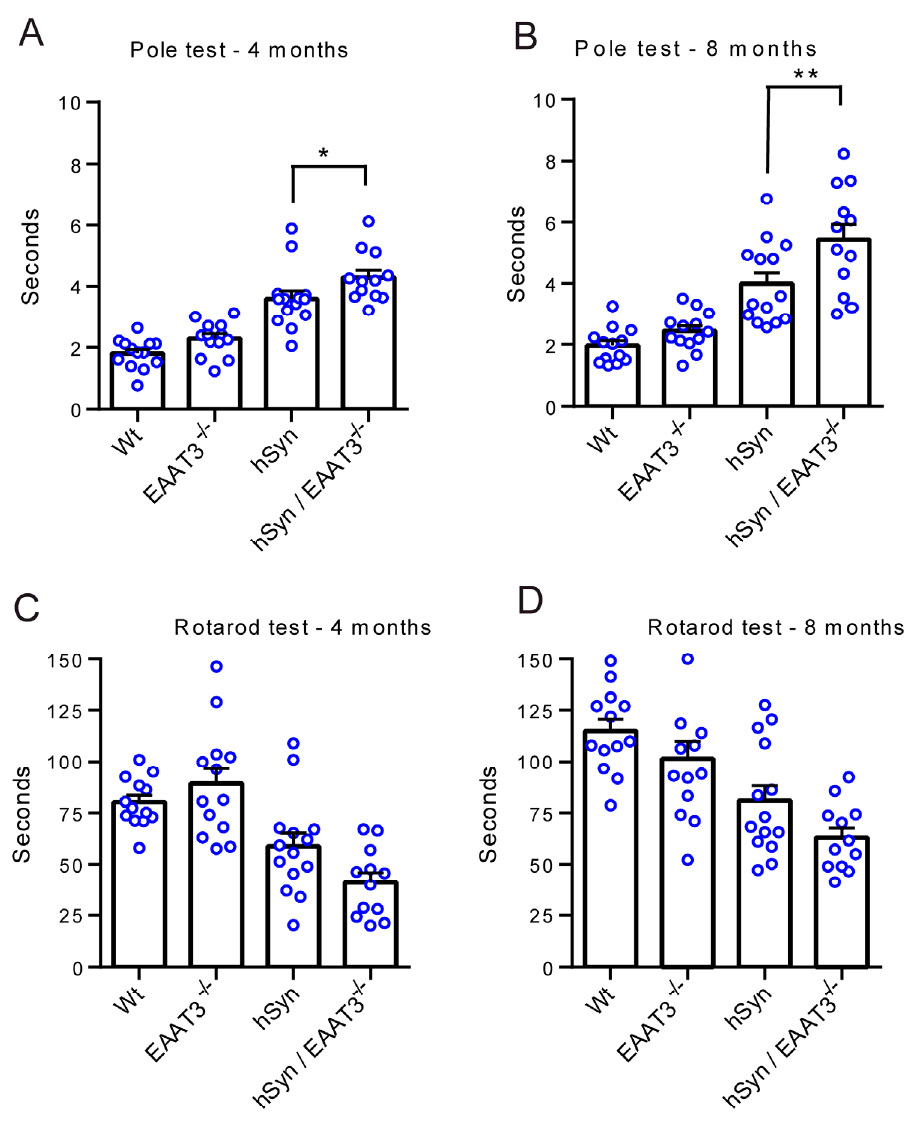
Figure 5. Accelerated motor decline in hSyn/EAAT3 − / − mice.Motor performance. ( A , B ) Time required for turnaround on the pole test at 4 and 8 months of age. * p < 0.05, ** p < 0.01; n = 8–11. ( C , D ) Time beforeto fall from the rotarod at 4 and 8 months of